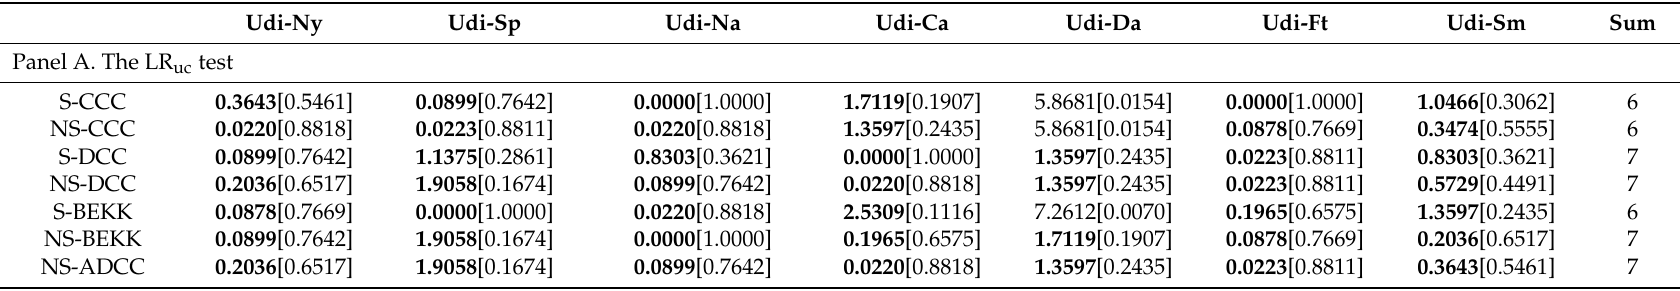
Table 9. The out-of-sample VaR forecasts performance of the equal weight currency-stock portfolios based on alternative accuracy tests for the 90%